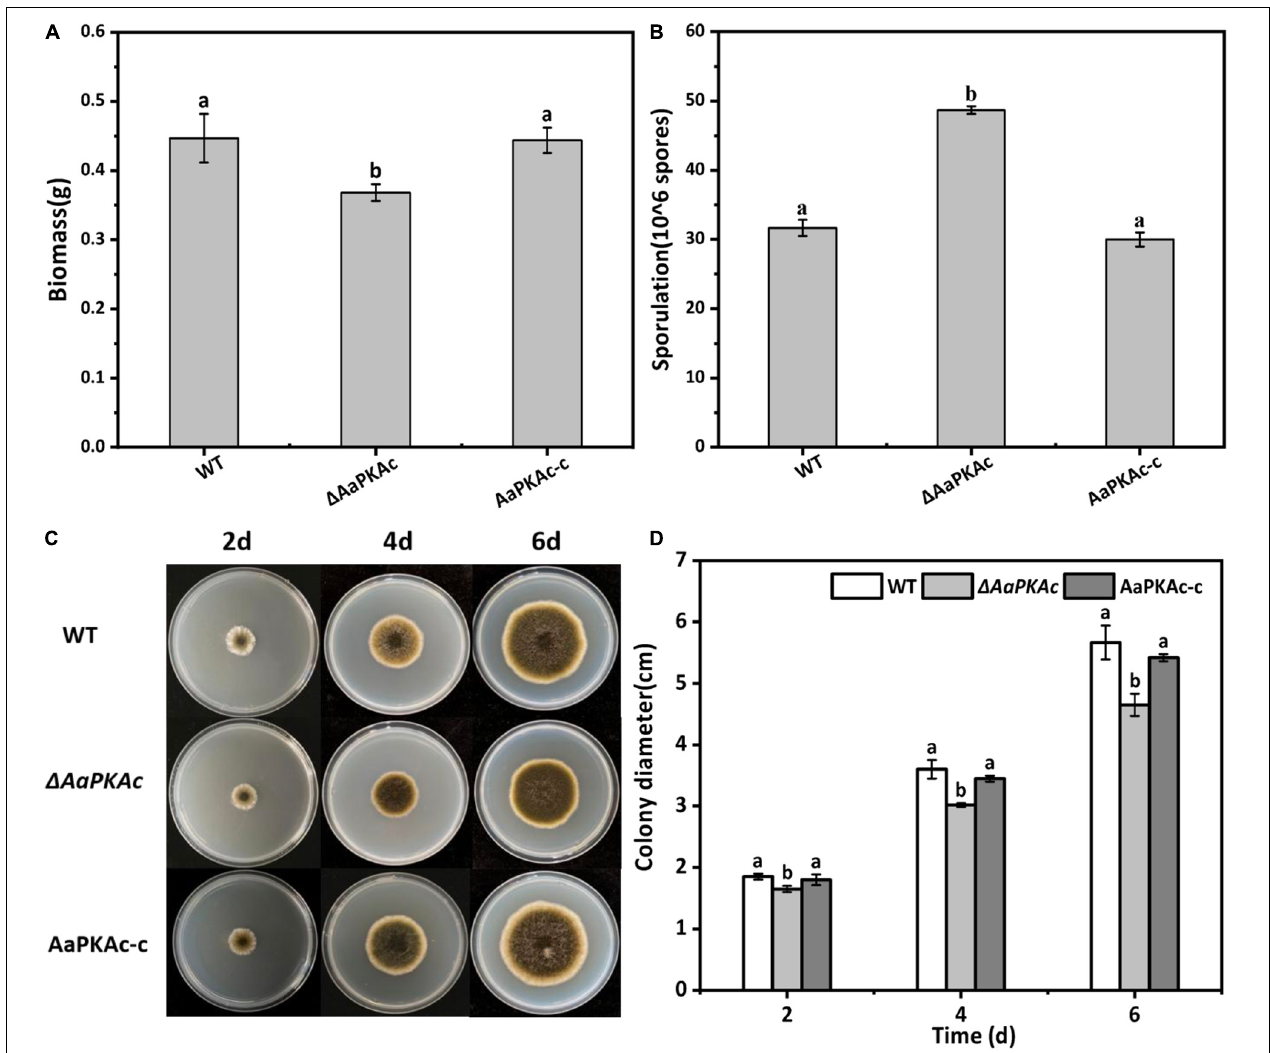
FIGURE 4 | Effect of AaPKAc on biomass (A) , spore production (B) , mycelial growth (C) , and colony diameter (D) of A. alternata. A 2- µ L spore suspension of the wild-type strain (WT), the (cid:49) AaPKAc mutant strain, or AaPKAc genetic complementation strain (AaPKAc-c) was inoculated in the center of the PDA medium and cultured at a constant temperature of 28 ◦ C and photographed and the diameter of the colony measured every day. Treatments followed by different letters are significantly different according to Duncan’s multiple-range test ( P <